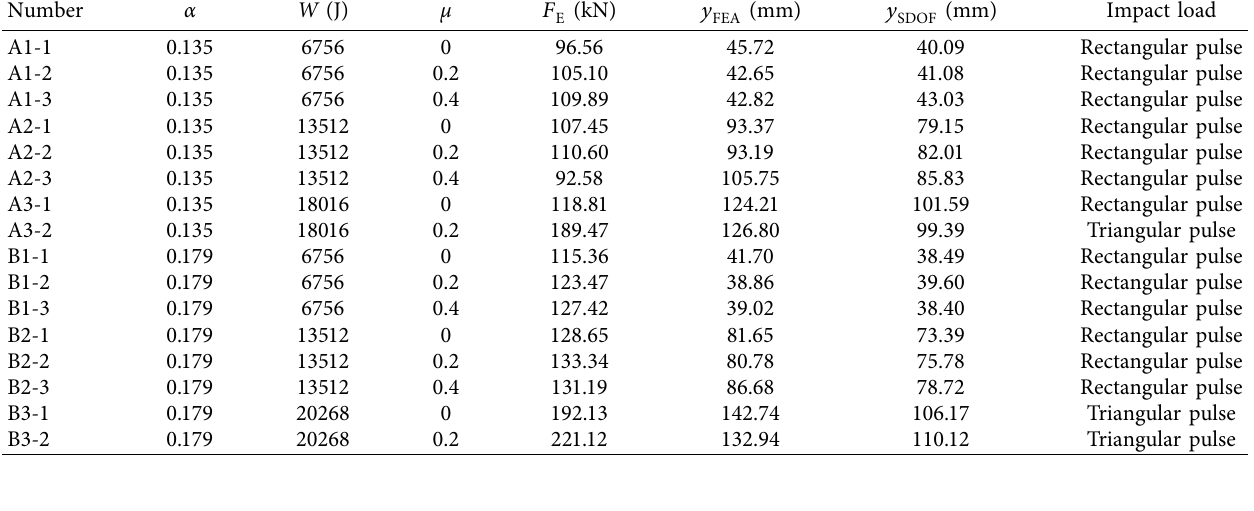
Table 5: Result comparisons between the theoretical calculation and numerical simulation.